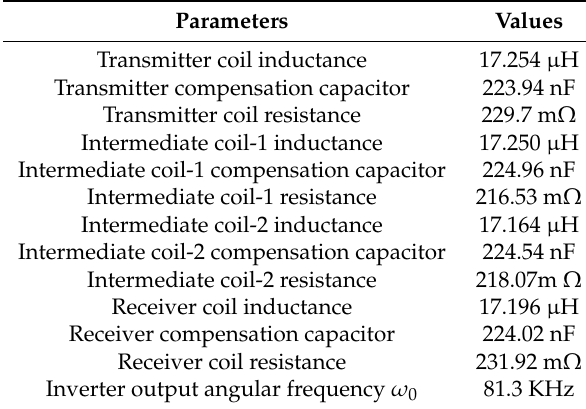
Figure 5. The transfer power of the system under different transfer distances. Table 2. System